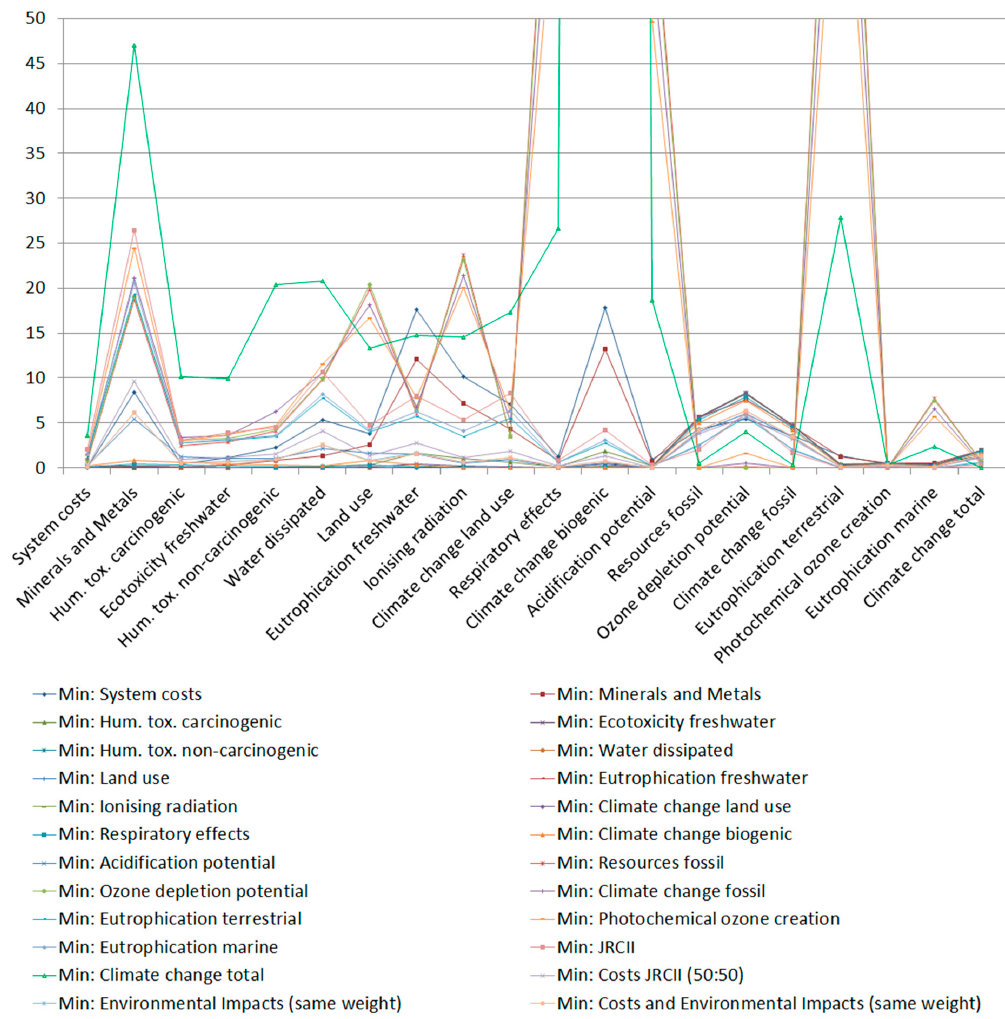
Figure A1. Normalised distances from optimum for the individual criterion depending on the objective function.